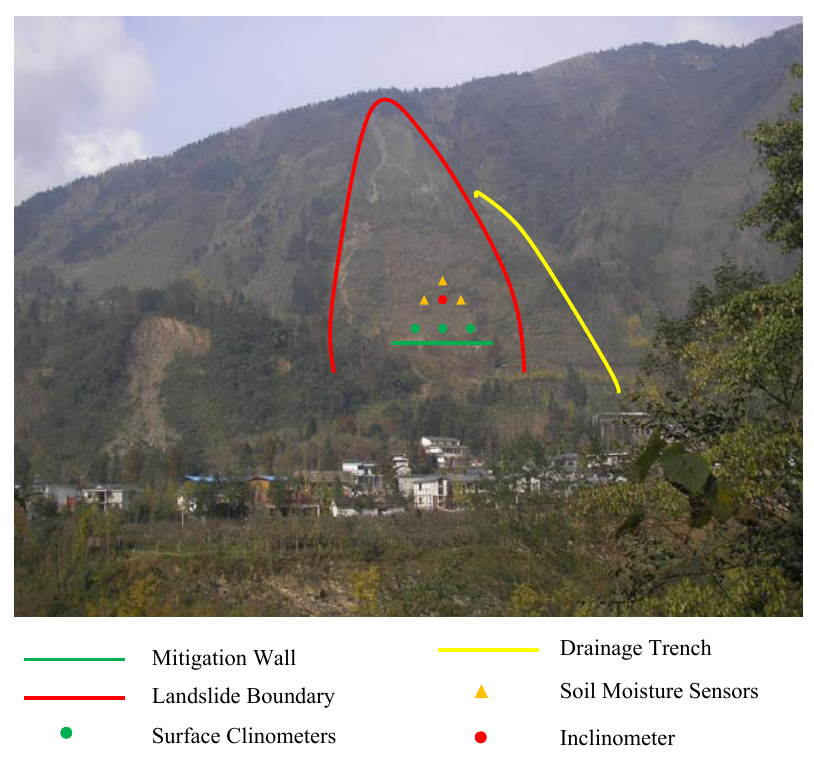
Figure 13. An overview of the Taziping landslide, the mitigation infrastructure and the currently available sensors for